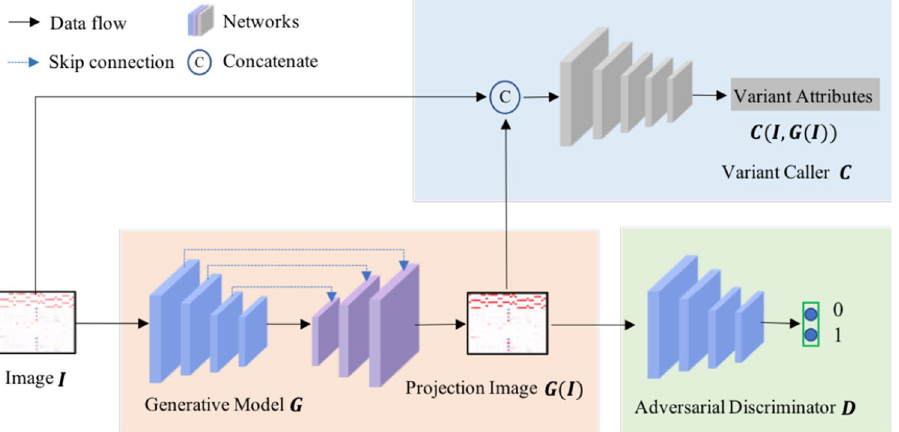
Figure 5. The framework of our LDV-Caller. Three sub-models, generative model G , adversarial discriminator D , and variant caller C are included. Detailed structures are in Table